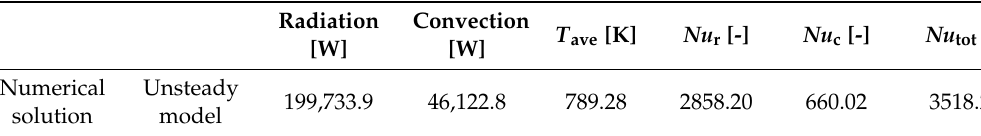
Table 5. Average heat transfer features on the kiln surface while heat flux on the kiln is constant. Radiation